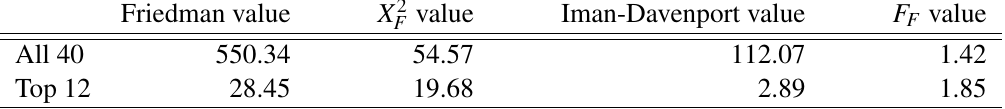
Figure 2: Rank distribution of the best variants of each family of algorithms across all instances. Table 4: Results of Friedman and Iman-Davenport tests for the techniques in Figure